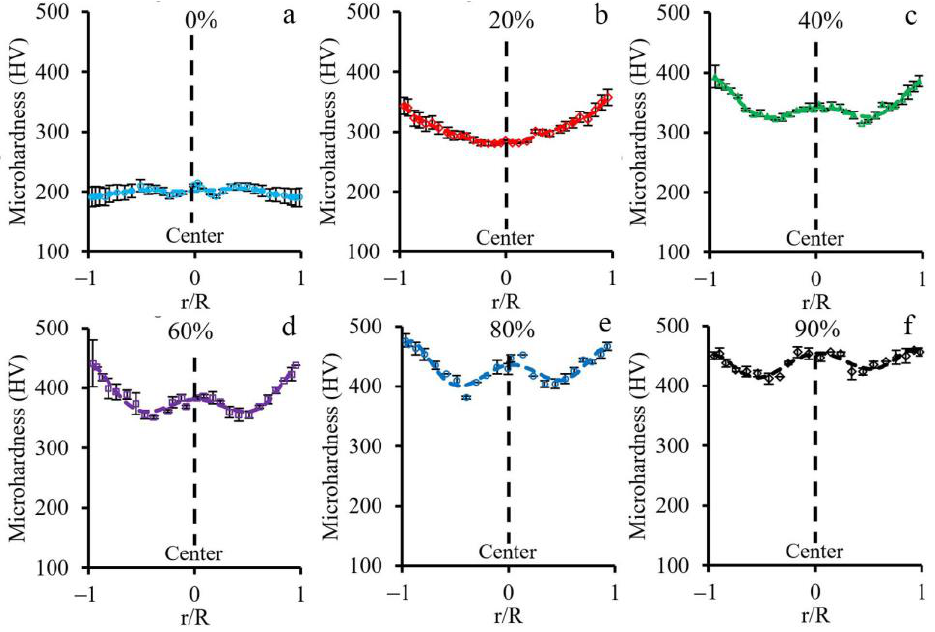
Figure 6. Microhardness distribution after cold rotary swaging with a reduction of ( a ) 0%, ( b ) 20%, ( c ) 40%, ( d ) 60%, ( e ) 80%, and ( f )